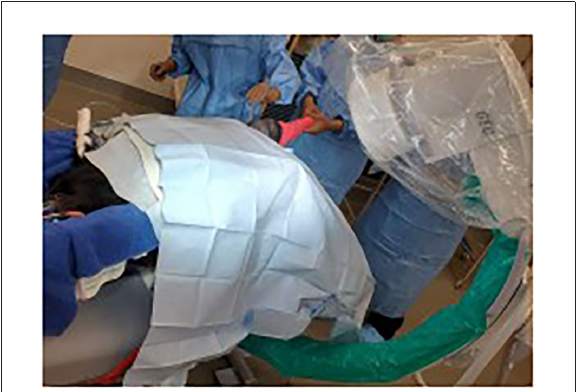
FIGURE1 Visualization of patient position. Dorsal recumbency at the level of the withers with pelvis tilted toward a right lateral recumbency. The back half of the calf is on a radiolucent plexiglass table extension that allows intraoperative fluoroscopic